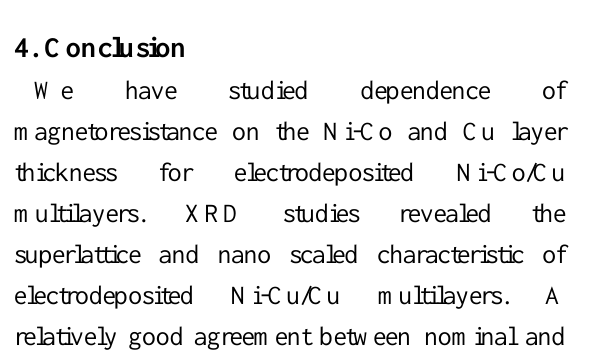
Fig. 8. The temperature dependent magnetization for Ni-Co/Cu multilayer samples; A) Ni- Co(3nm)/Cu(3nm), B)